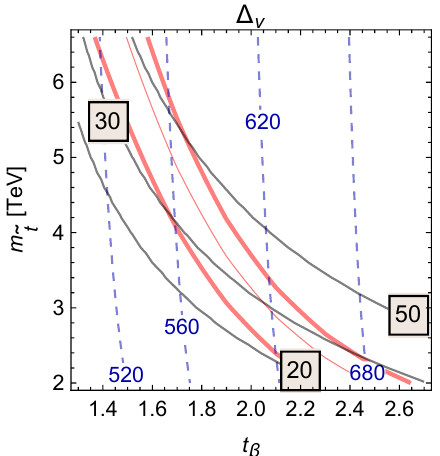
Figure 9 . The total tuning (cid:1) v of the electroweak scale v in the F -term supersymmetric UV completion of the TMNT model with respect to all dimensional parameters added in